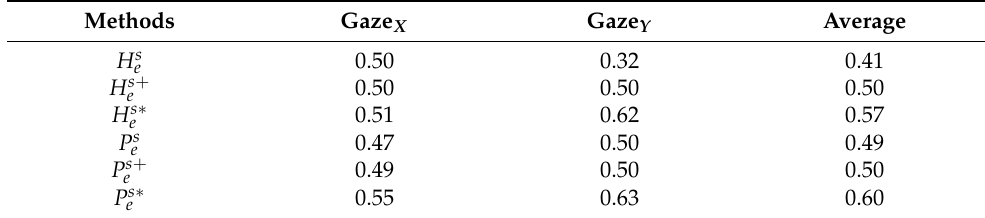
Table 2. The Gaussian PDF of real gaze estimations between − 0.5 ◦ and 0.5 ◦ .